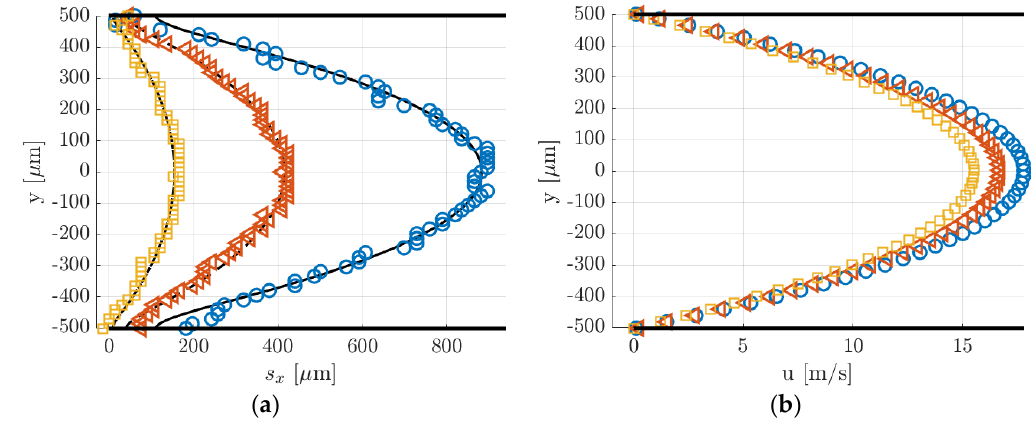
Figure 14. ( a ) Displacement data computed by applying the Gaussian fitting per line to the images of Figure 13. The black lines represent the numerical solutions for the displacement profile provided by the reconstruction method; ( b ) velocity reconstruction from the displacement data in ( a ): Δ𝑡 = 10 µs ( ☐ ), 25 µs ( ), and 50 µs ( O ).